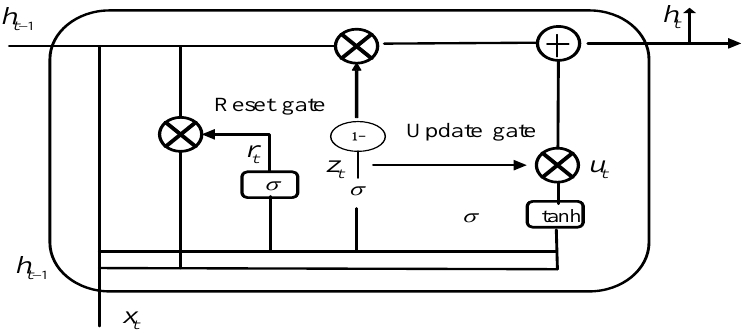
Figure 2. GRU internal unit structure diagram.